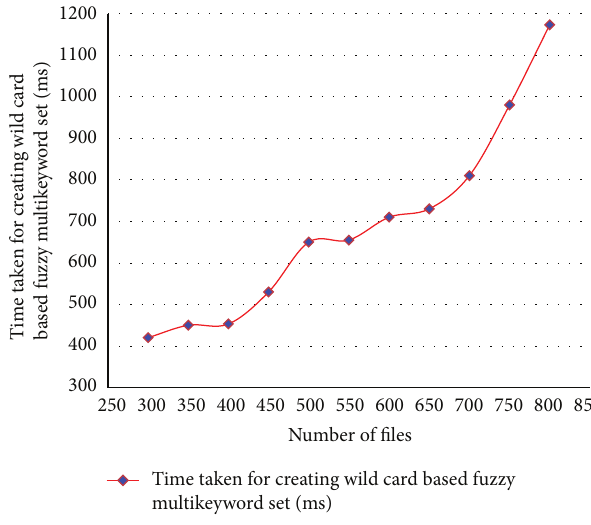
Figure 3: Time taken for creating wild card fuzzy multikeyword set for ACMFS.